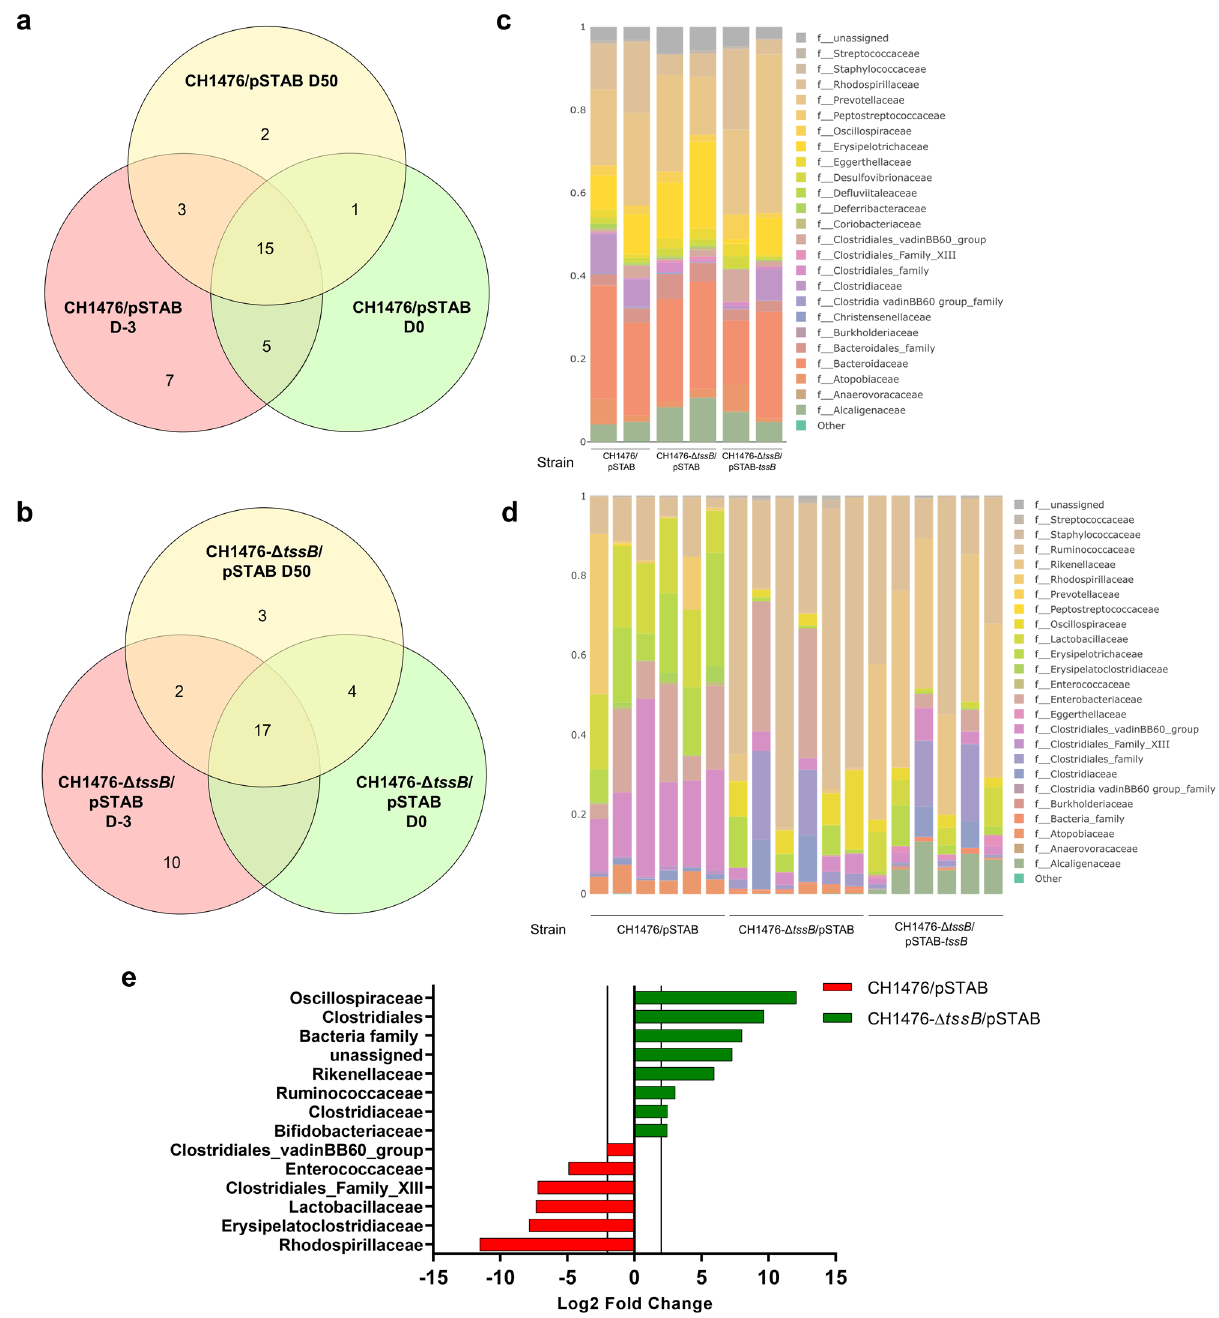
Figure 5. Modulation of composition of mice intestinal microbiota linked to the presence of K. pneumoniae and role of T6SS-1. Venn diagrams for number of bacterial families in fecal microbiota shared among the different infected groups of mice: ( a) WT CH1476 (CH1476/pSTAB) and ( b) T6SS-1 derived mutant (CH1476- Δ tssB /pSTAB) at different time points. Community composition plot for relative abundance of bacterial families in fecal microbiota at (c). D-3 and ( d) D+50 infection time points in the different infected groups of mice. Each bar represents a single mouse. (e) Differential analysis showing families’ relative abundance between WT CH1476 (red) and T6SS-1 derived mutant (green) at D+50 PI. The dashed line indicates the limit of detection (− 2 or + 2 Log 2 Fold